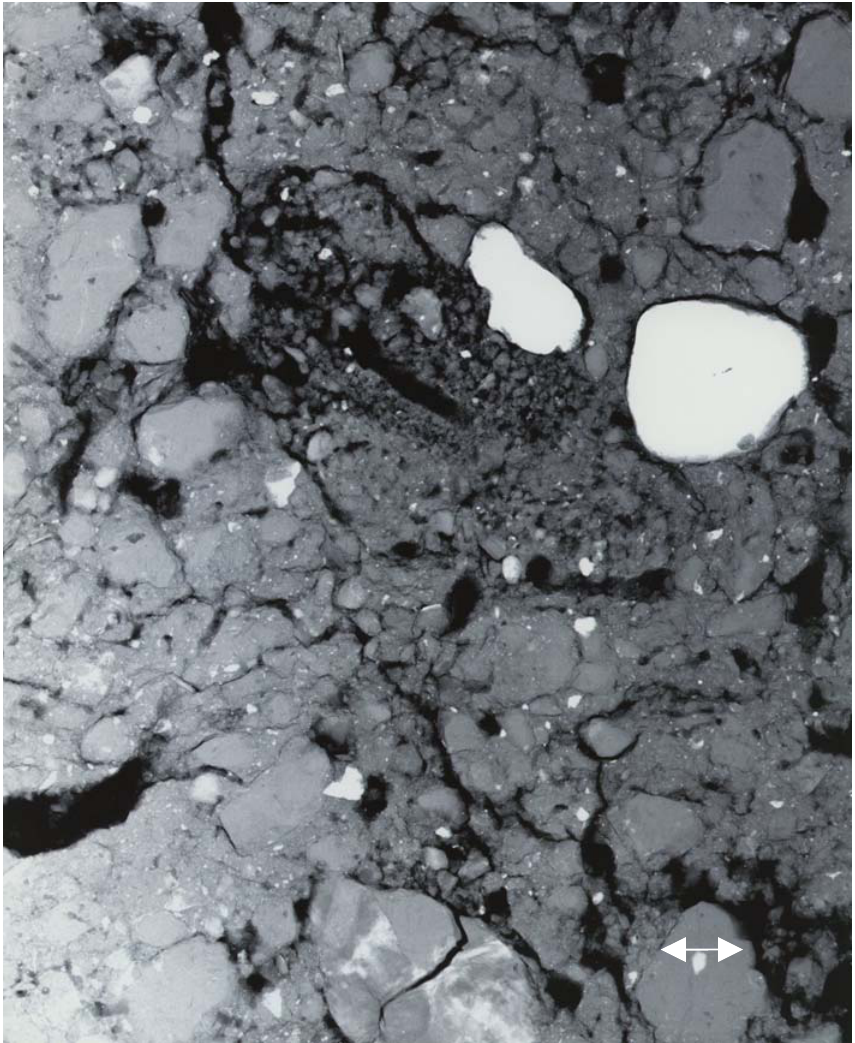
Figure 5. PCX image of a cross-sectional soil sample (a few mm thick): 30 kVp, 40 μ A; source-to-sample distance = 10 cm; sample-to-detector distance = 90 cm; exposure time 60